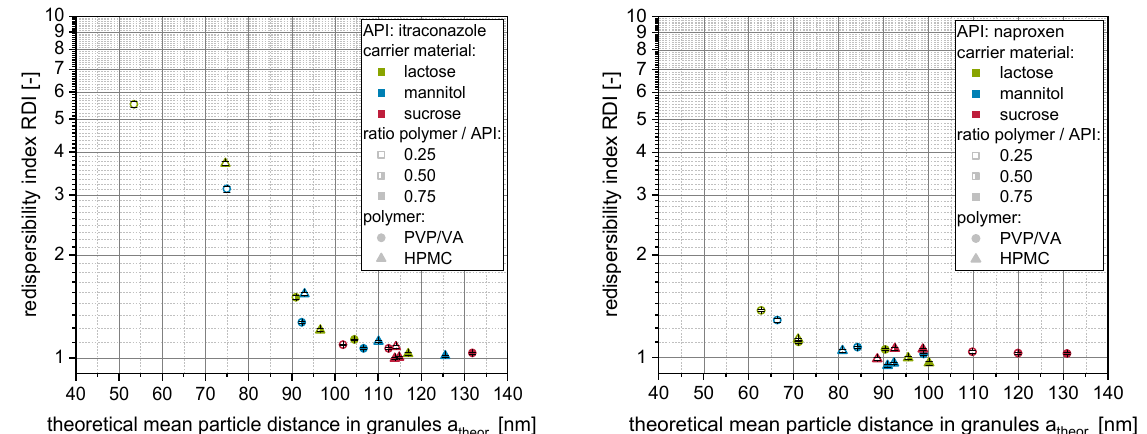
to API). The granules were completely redispersible when theoretical mean distances of nanoparticles within the granules were larger than approx. 100 nm (itraconazole) and 80 nm (naproxen), respectively. These differences indicate that API-specific characteristics (e.g., particle shape, particle size distribution, physicochemical properties) influence the minimum mean nanoparticle distance that is sufficient for an appropriate redispersion. However, the minimum nanoparticle distances are in the same order of magnitude as those shown in the study of Steiner et al. [23] (particle distance of 150 nm for complete redispersibility considering the factor of ½ as particle center distances were calculated), highlighting the applicability of the corresponding approach to other nanoparticle-con- taining composites. The correlation of the redispersibility of nanoparticles from granules and the theoret- ical mean distances of the nanoparticles within the granules based on insoluble glass beads as carrier material can be seen in Figure 9.